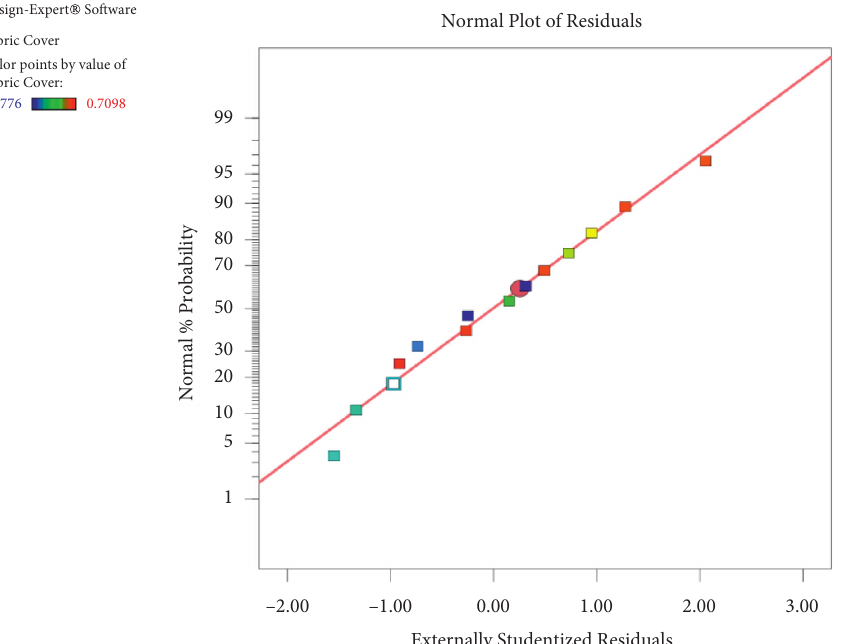
Normal Plot of Residuals